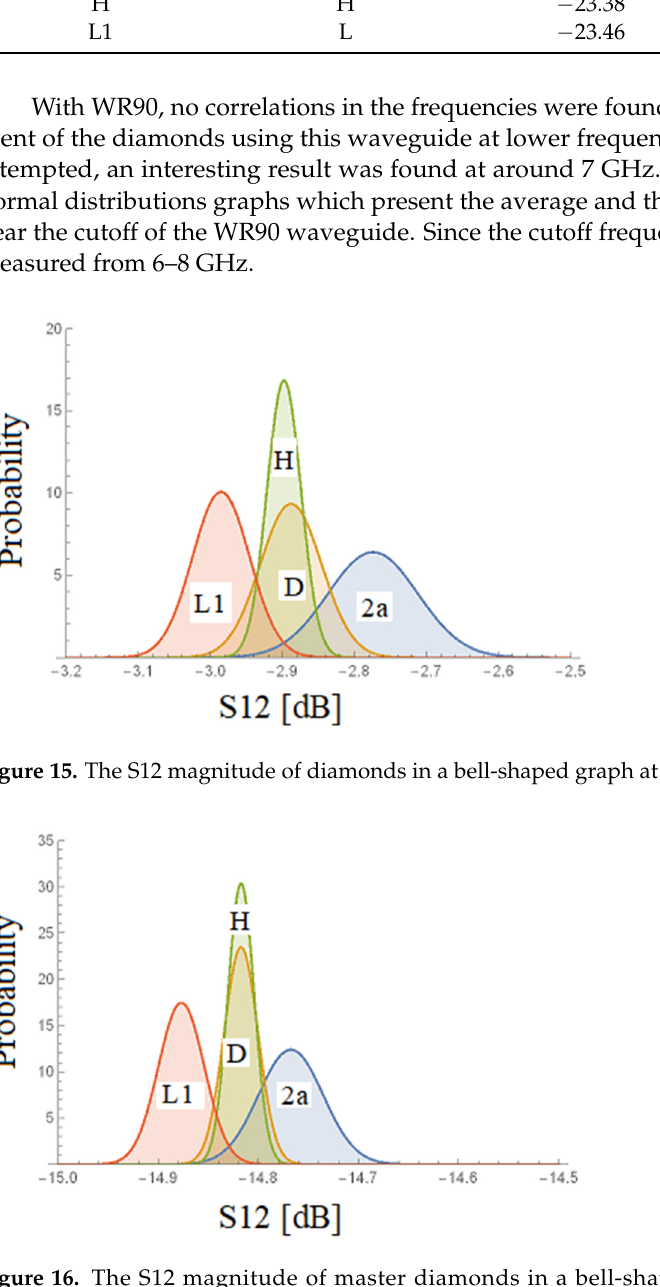
Figure 16. The S12 magnitude of master diamonds in a bell-shaped graph at a frequency of 7.0375 GHz.